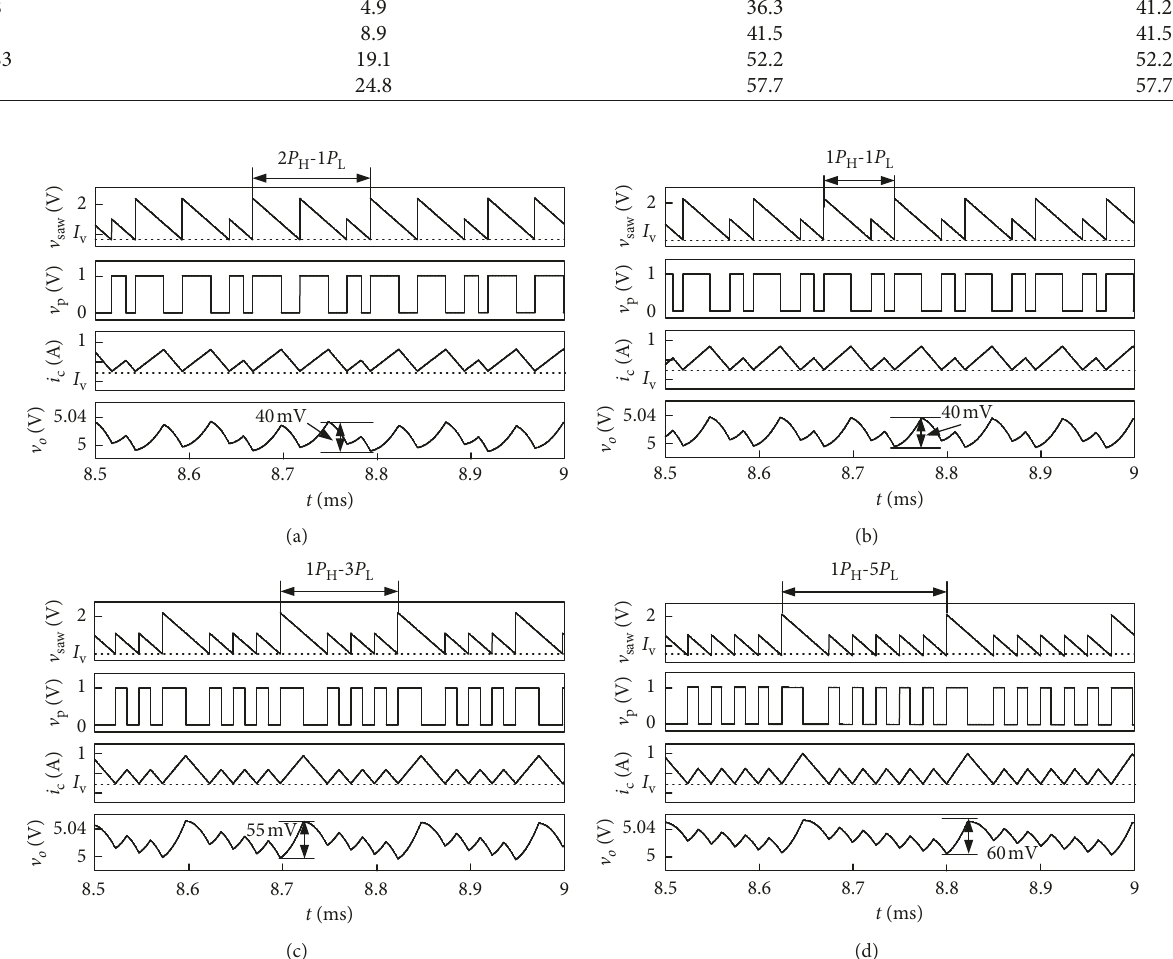
Figure 7: Simulation waveforms of the DCPT-controlled buck converter. (a) V